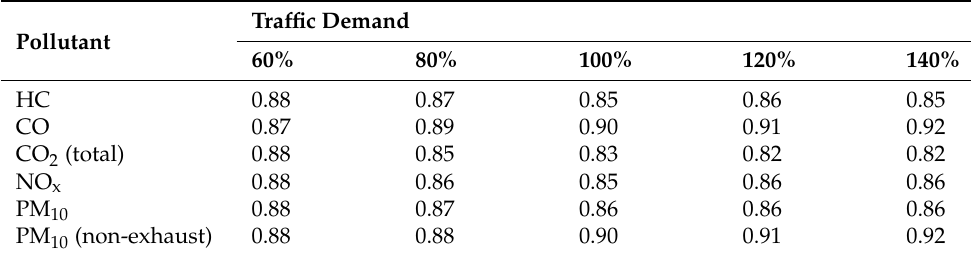
Table 3. Change in the emissions per km (link based vs. OD-pair based calculation) (one street type for